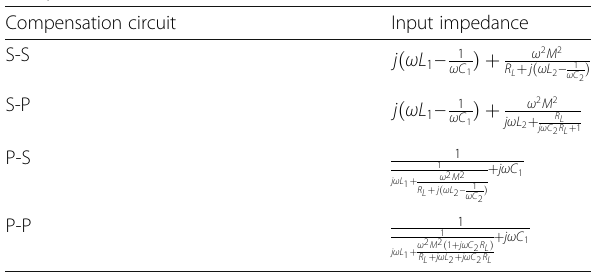
Table 1 Total impedance of four kinds of resonant compensation circuits Compensation circuit